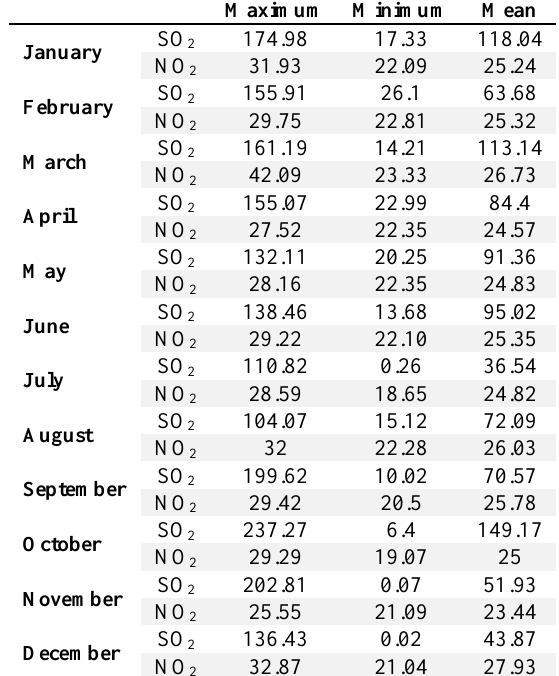
Table 2 SO 2 and NO 2 hourly-average concentrations (μg m -3 ) at Bukan city from 2014 to 2015.